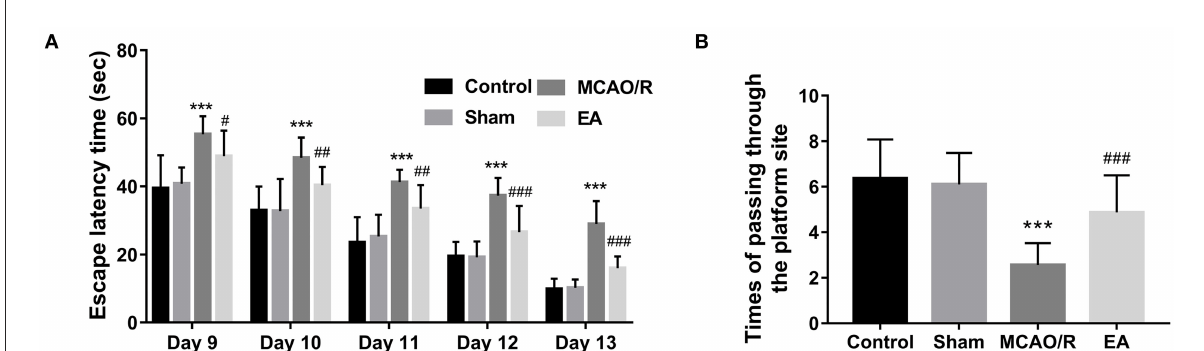
expressed proteins in the EA vs. MCAO/R model group that might be implicated in brain and nerve development were filtered out based on GO enrichment analysis in Supplementary Table 7 using the abovementioned methods. The screened GO biological process terms and proteins are shown in Supplementary Tables 8, 9, respectively. PPI analysis of these proteins revealed that there were potential regulatory networks among eight proteins [i.e., Pak4, Akt3, phosphatidylinositol 3,4,5-trisphosphate 3-phosphatase and dual-specificity protein